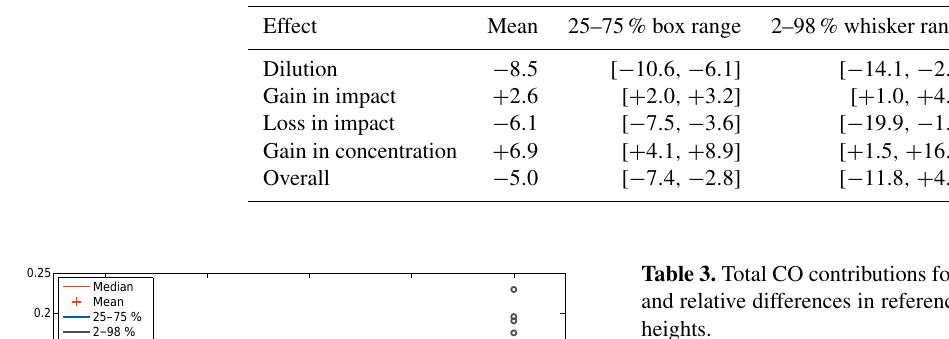
Figure 4. Temporal changes in the overall difference in emission sensitivity (cid:49)S tot enveloped by the positive and negative contributions that correspond to increase/decrease in footprint layer height (cid:49)h ± and the defined effects of Eq. (8) based on 216 simulations. Differences by footprint layer variations are calculated relatively in reference to the constant 300m assumption. Table 2. Mean values and calculated intervals in per cent for the interquartile range and the 2nd to 98th percentile as shown in the box-and- whisker plot in Fig. 5.